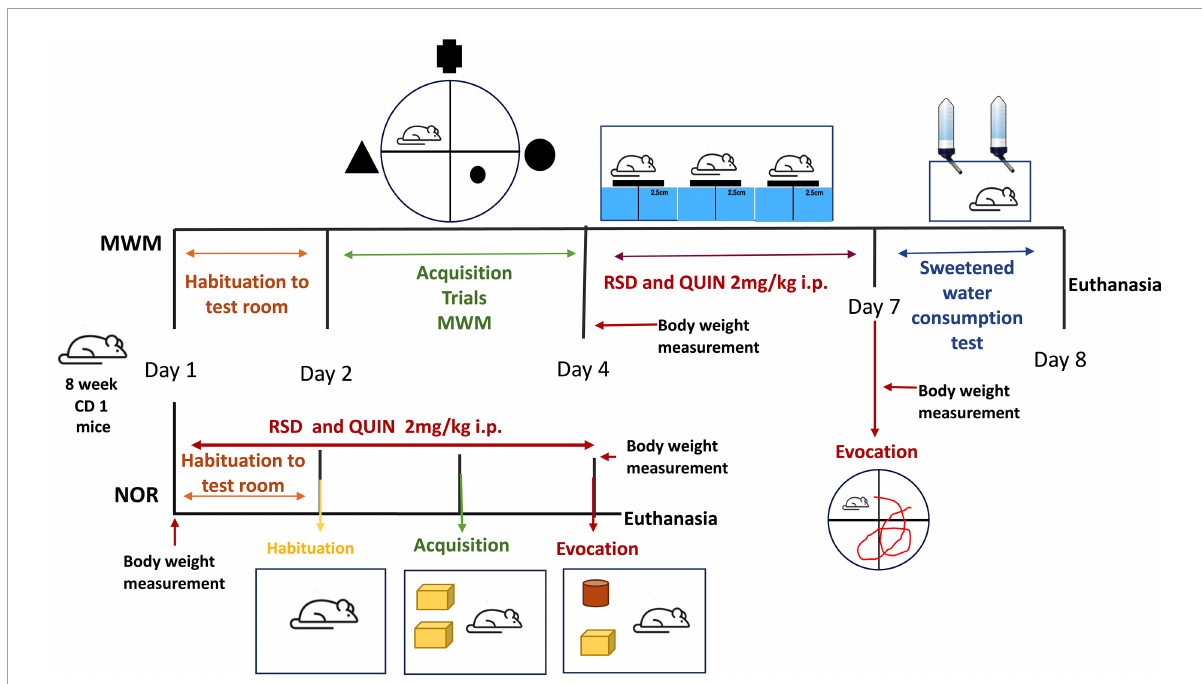
FIGURE1 Schematic representations of REM-sleep deprivation (RSD) QUIN administration doses, regimens, and temporal strategies of behavioral tasks. The mice were subjected to 72 h of RSD with or without QUIN administration. The two behavioral tasks are indicated. For the Morris water maze (MWM), RSD was administered after acquisition and before the evocation